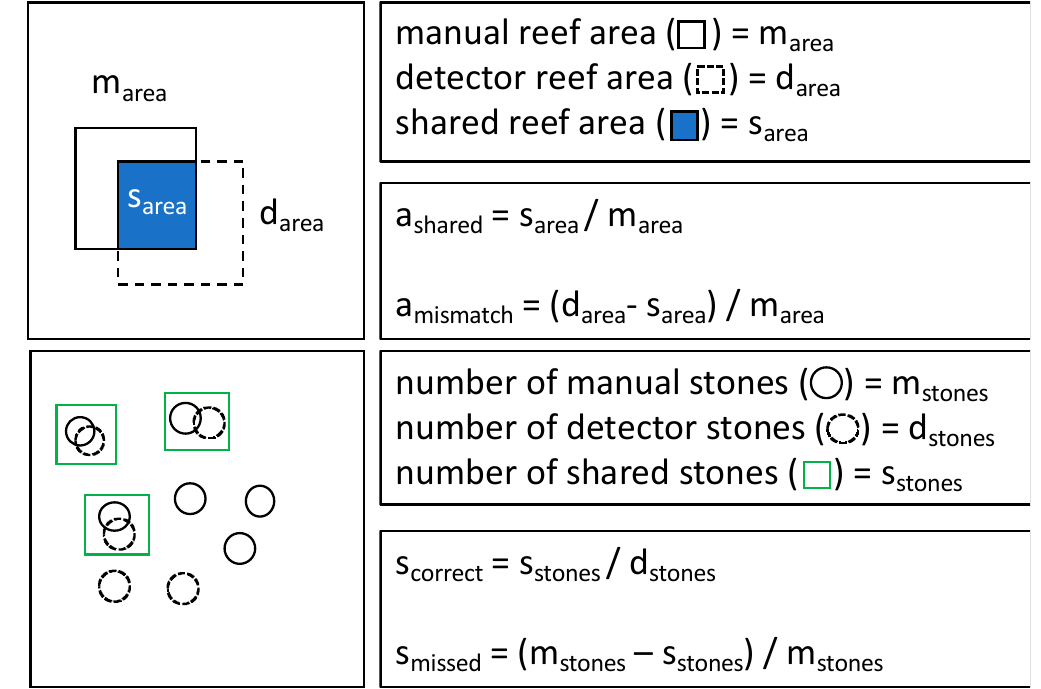
Figure 4. Schematic representation of the calculation of the factors used in Equation 1.